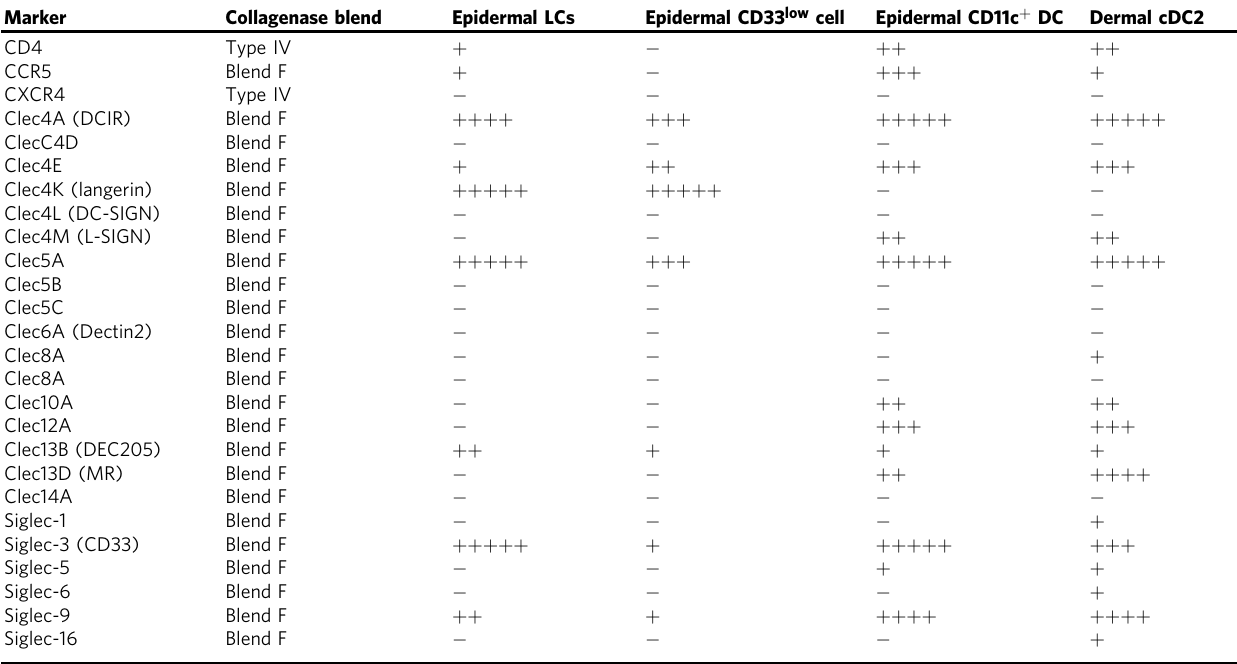
Table 1 Pathogen binding receptor surface expression pro fi les of epidermal MNPs